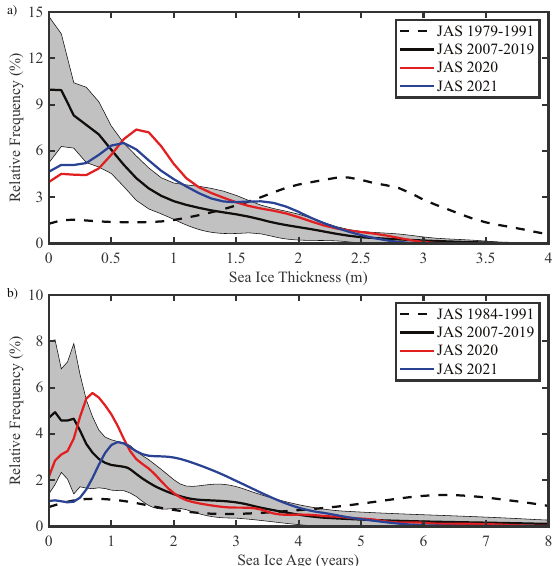
Fig. 4 Frequency distribution of summer (July – September) sea ice characteristics in the region of interest. a PIOMAS sea ice thickness distribution and b NSIDC sea ice age distribution. Climatological distributions for 1979 – 1991 (1984 – 1991 for ice age) and 2007 – 2019 are shown as well as distributions for 2020 and 2021. The shading represents one standard deviation above/below the 2007 – 2019